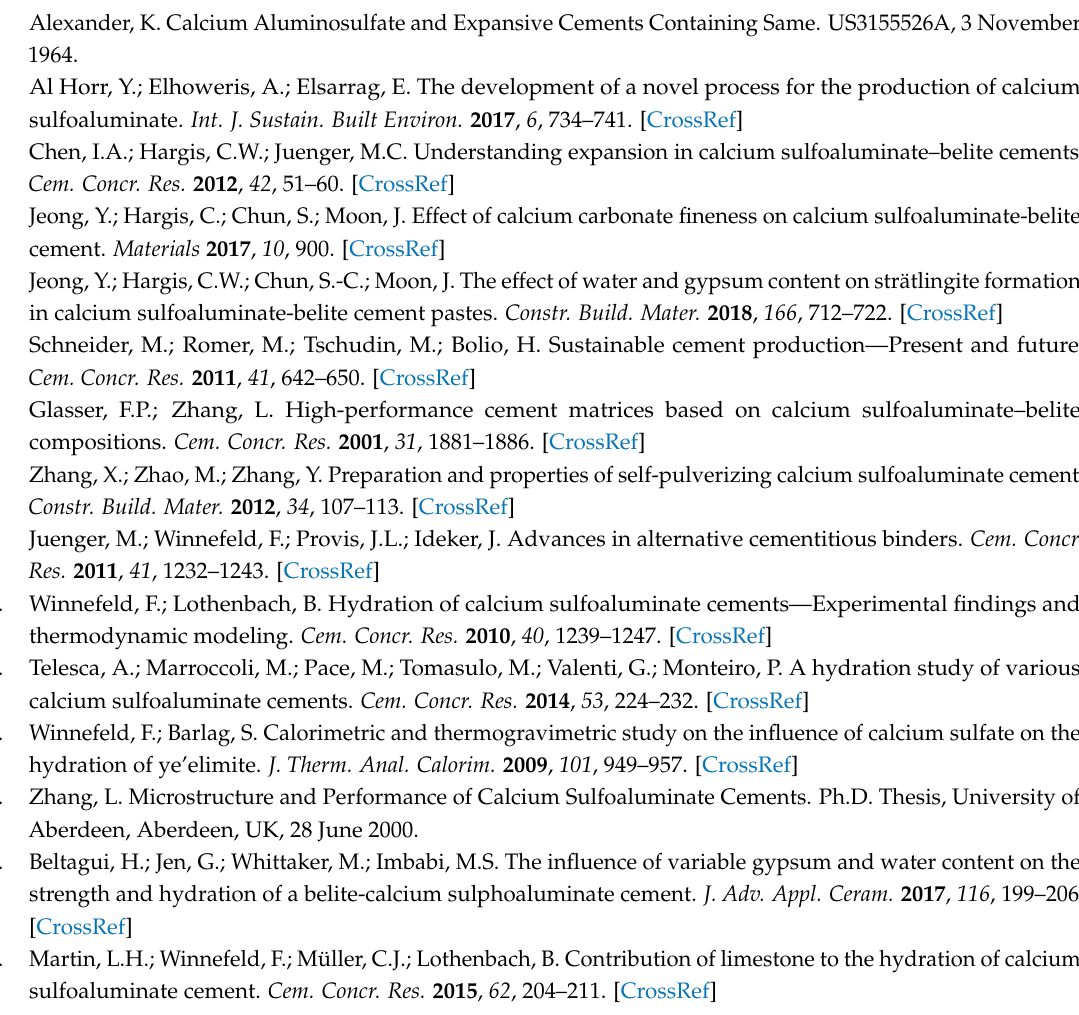
s1, Table S1: Averaged compressive strength and its standard deviation, Figure S1: QXRD results for (a) CSA1-30, (b) CSA2-30, (c) CSA1-60, (d) CSA2-60, (e) CSA1-90, and (f)